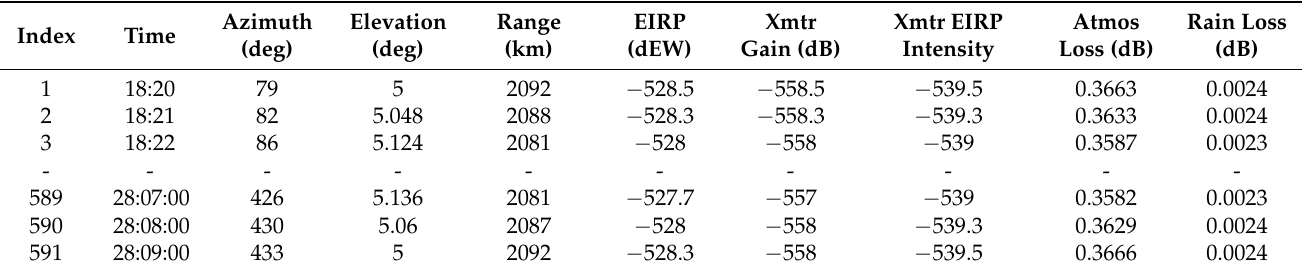
Table 1. Example of the records used for the training stage. The first and last three records. Reprinted with permission from ref. [1]. Copyright 2021